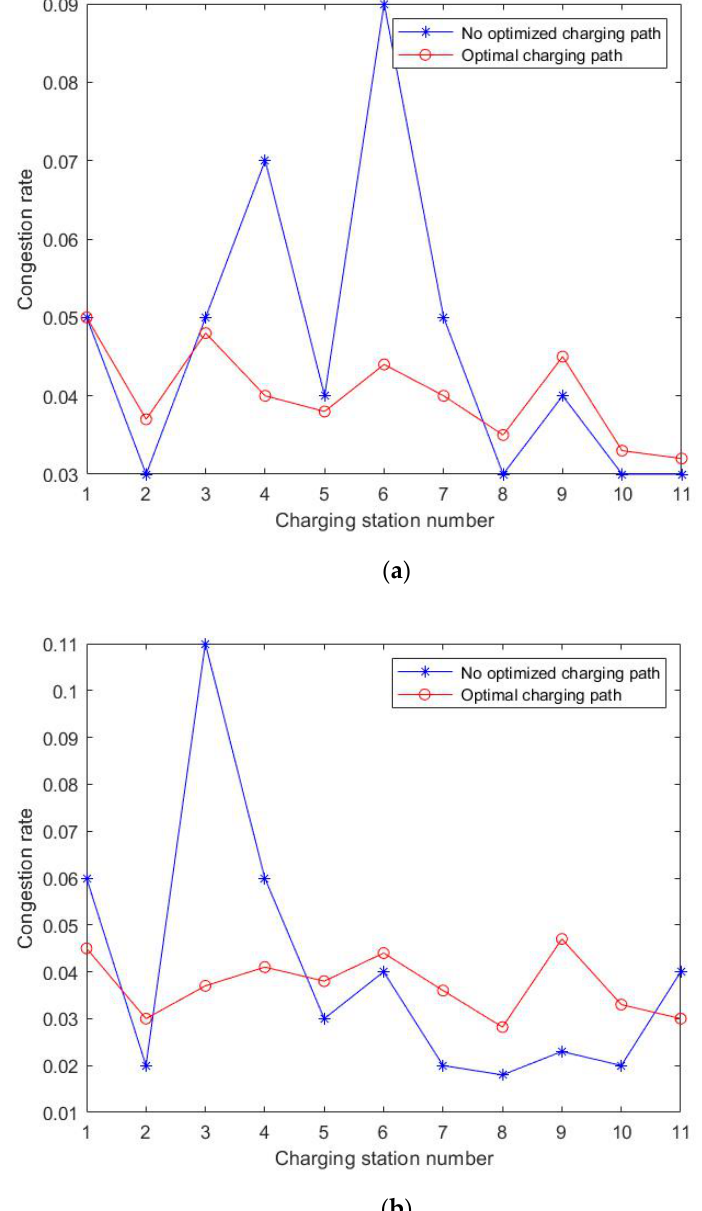
Figure 9. Comparison of road congestion rates near charging stations. ( a ) Average of road congestion rate near each charging station at 10:00; ( b ) Average of road congestion rate near each charging station at 15:00.